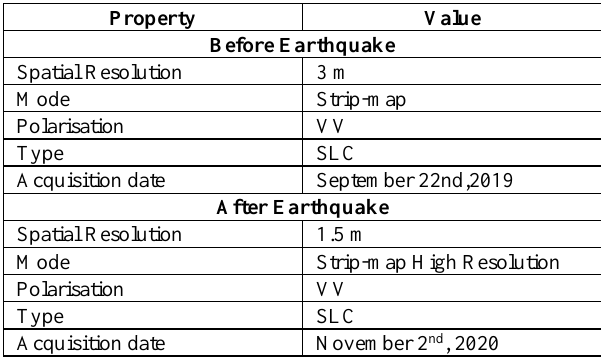
Table 2. Properties of the SAR image.